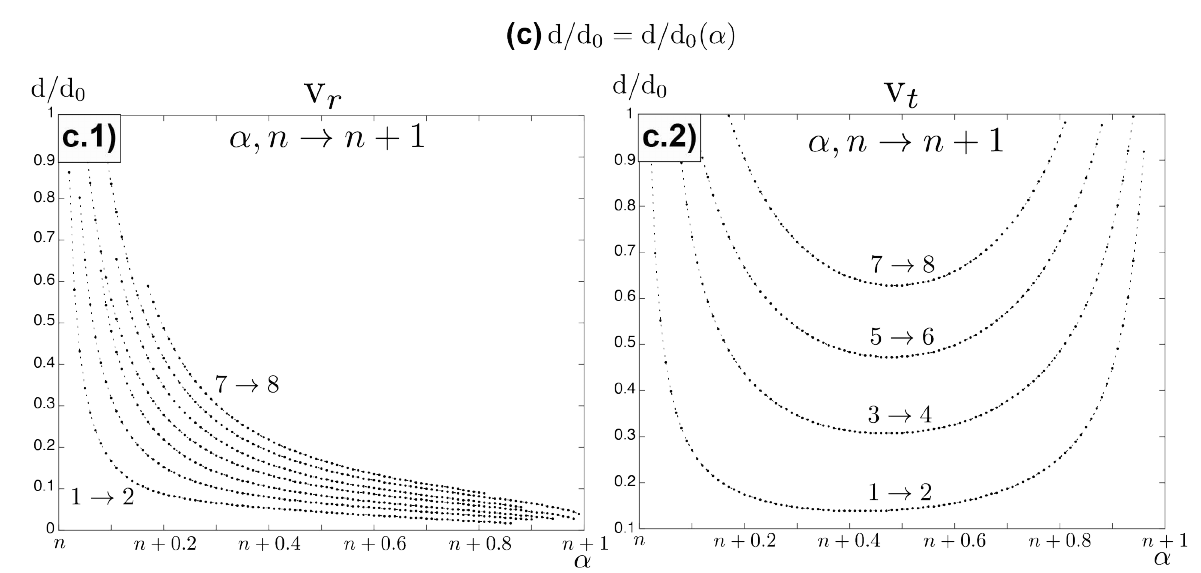
Figure 1. Numerical simulations. ( a ) Fractional vortex beam with α = 2.15: ( a.1 ) initial phase profile, ( a.2 ) far-field phase profile, ( a.3 ) far-field intensity profile, and ( a.4 ) far-field intensity profile in logarithmic scale. ( b ) Fractional vortex beam with α = 3.63: ( b.1 ) initial phase profile, ( b.2 ) far-field phase profile, ( b.3 ) far-field intensity profile, and ( b.4 ) far-field intensity profile in logarithmic scale. ( c ) Normalized distance measured from the position of the unit vortices to the center. ( c.1 ) Distance for the resident vortices v r in transitions from 1 → 2 to 7 → 8. ( c.2 ) Distance for the tourist vortices v t , present only in transitions starting with odd n, from 1 → 2 to 7 →